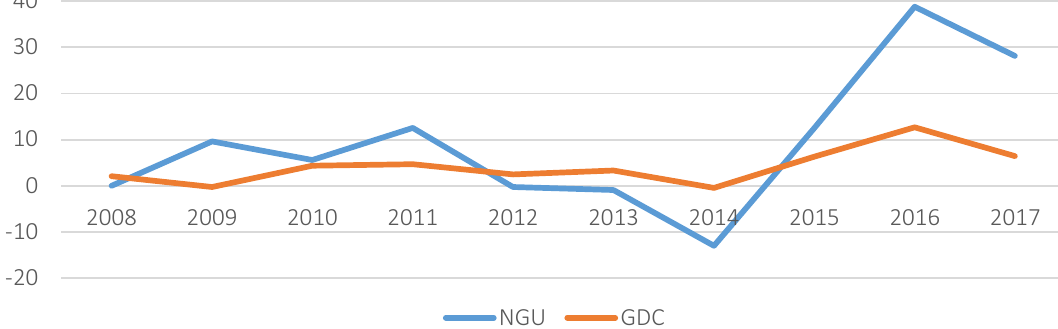
Figure 2. Operating profitability of NGU and regional GDCs,